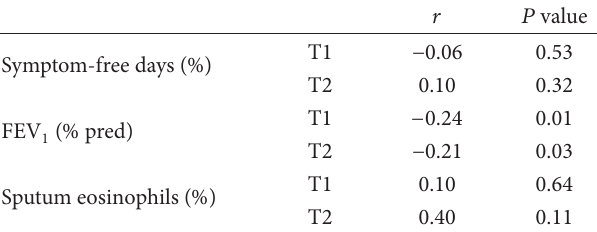
1 :forcedexpiratoryvolumein1second.eindividual changes from baseline of uEPX and eos are expressed as ratios. For FEV 1 and symptom-free days, the changes are expressed as the absolute differences of the measured percentages. Numbers evaluable for the change % from baseline of